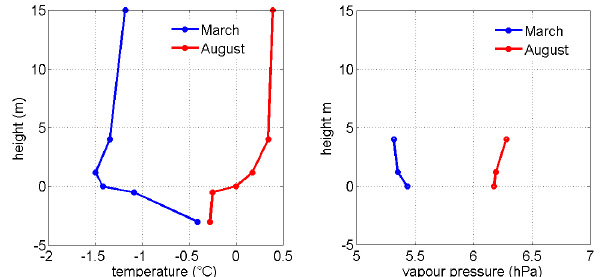
Fig. 5. Mean vertical profiles of temperature (air, ice, rock; left) and vapour pressure (right) measured at the EP measurement site during the warmest and coldest moth of the year.